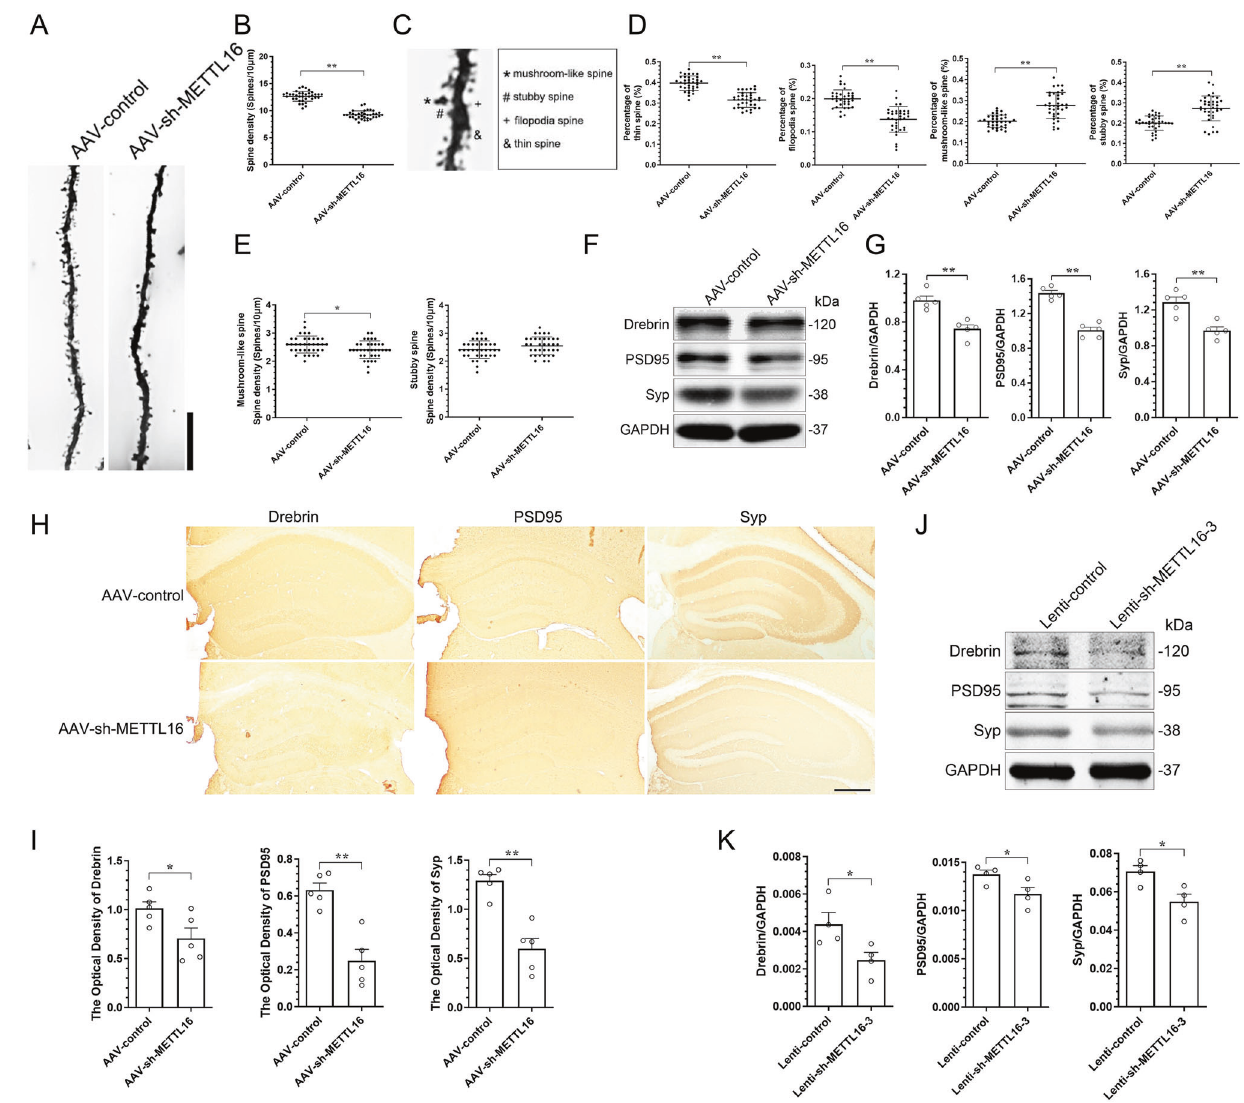
Fig. 3 Knockdown of METTL16 in the hippocampi disrupts hippocampal dendritic spines and plasticity-related proteins. A , B Representative Golgi-Cox impregnated spines ( A ) and quanti fi cation of the spine density ( B ) in the hippocampi of the AAV-control and AAV-sh-METTL16 group ( n = 36 neurons from 6 mice per group); Scale bars = 10 μ m. C , D Representative images of the morphology of mushroom-like, stubby, fi lopodia, and thin spines ( C ) and quanti fi cation of the percentage of tin, fi lopodia, mushroom-like, and stubby spine ( D ) in the hippocampi of the AAV-control and AAV-sh-METTL16 group ( n = 36 neurons from 6 mice per group). E Quanti fi cation of the spine density of mushroom-like and stubby spine in the hippocampi of the AAV-control and AAV-sh-METTL16 group ( n = 36 neurons from 6 mice per group). F , G Representative images ( F ) and quanti fi cation of Drebrin, PSD95, and Syp ( G ) in the hippocampi of the two groups of mice were tested by western blotting ( n = 5). H , I Representative IHC images ( H ) and quanti fi cation of Drebrin, PSD95, and Syp ( I ) in the hippocampi of the two groups of mice ( n = 5); Scale bars = 500 μ m. J , K Representative images ( J ) and quanti fi cation of Drebrin, PSD95, and Syp ( K ) in the HT22 cells of the Lenti-control group ( n = 4) and Lenti-sh-METTL16 group ( n = 4) tested by western blotting. Data shown as the mean ± SEM. P- values were determined by two-tailed t -test. * P < 0.05, ** P <